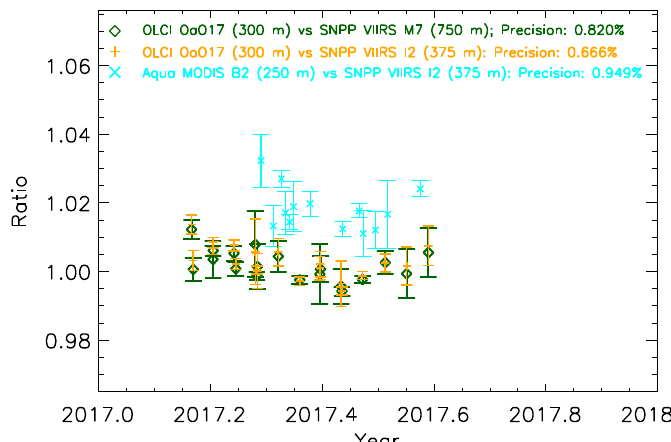
Figure 19. Inter-RSB comparisons of OLCI Oa17 versus SNPP VIIRS M7 and I2, occurring exclusively over the northern polar region, demonstrate the 750-m (green diamonds) and 375-m (orange crosses) regimes. The subset of Aqua MODIS B2 versus SNPP VIIRS I2 comparison occurring over the northern polar region (cyan diagonal crosses) is shown for comparison.